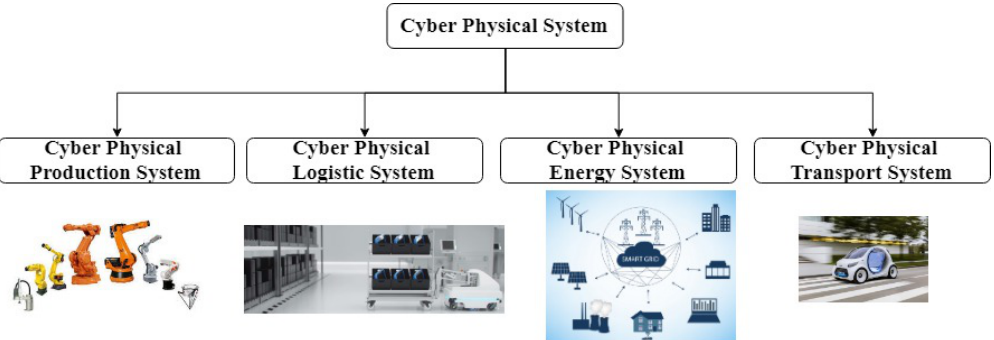
Figure 1. Examples of cyber physical